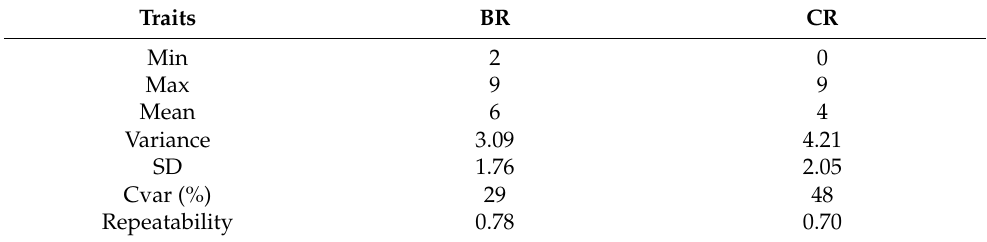
Table 1. Summary statistics and trait repeatability estimates for BR and CR. Min refers to the lowest scored value; Max refers to the highest scored value; SD refers to the standard deviation, Cvar refers to the coefficient of